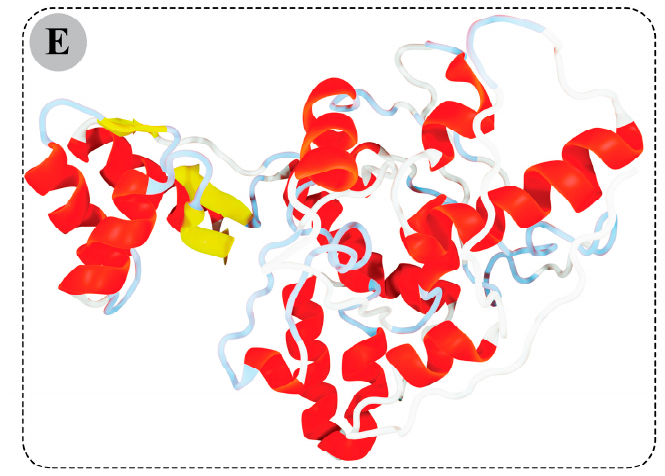
Figure 3. Tertiary structure modelling, refinement, and validation of the chimeric vaccine construct. Ramachandran plot details of modelled structure ( A ) before and ( B ) after refinement. ProSA web server generated a Z-score graph of the modelled structure ( C ) before and ( D ) after refinement, depict-